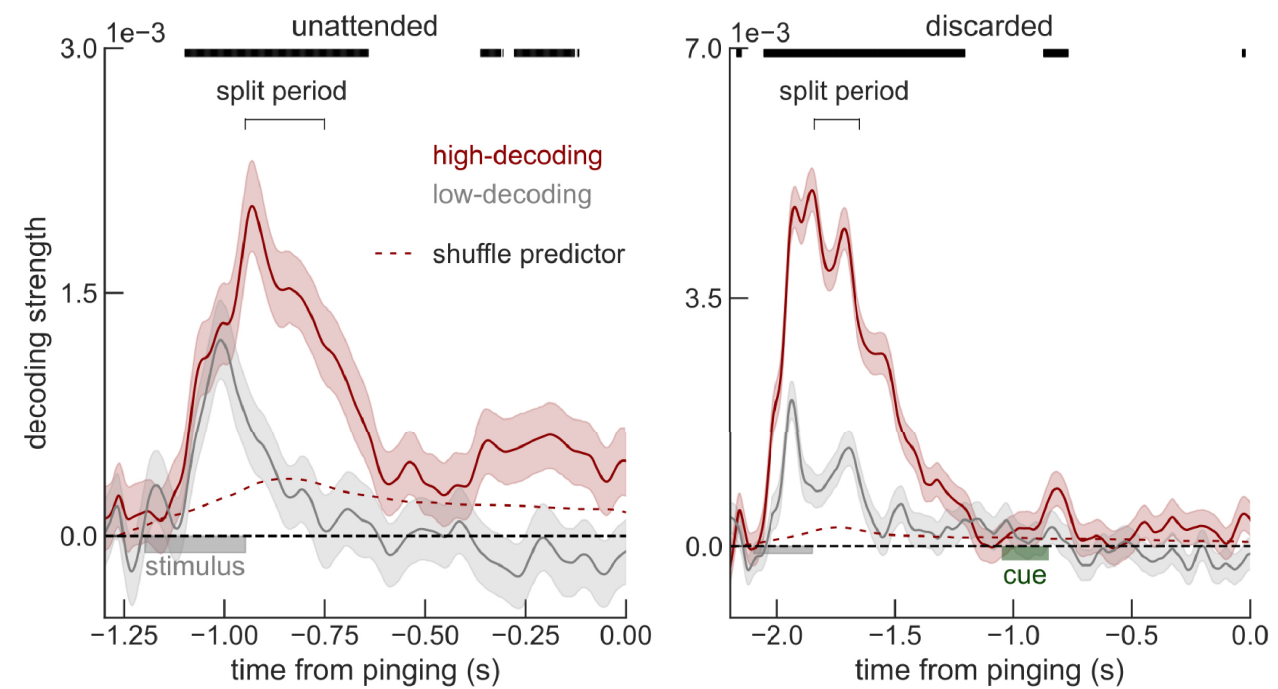
Fig 3. Sessions with high early-delay (split period, Methods) voltage decoding have a sustained code for unattended memories (left, red), but not for discarded memories (right). Error bars are sem. Decoding strengths from high-decoding sessions were compared to the shuffle predictor (top black bars mark significant deviation, one-sided p < 0.05, Methods). Time course and data are similar to Fig 1A and 1B. Data from Wolff and colleagues (2017)